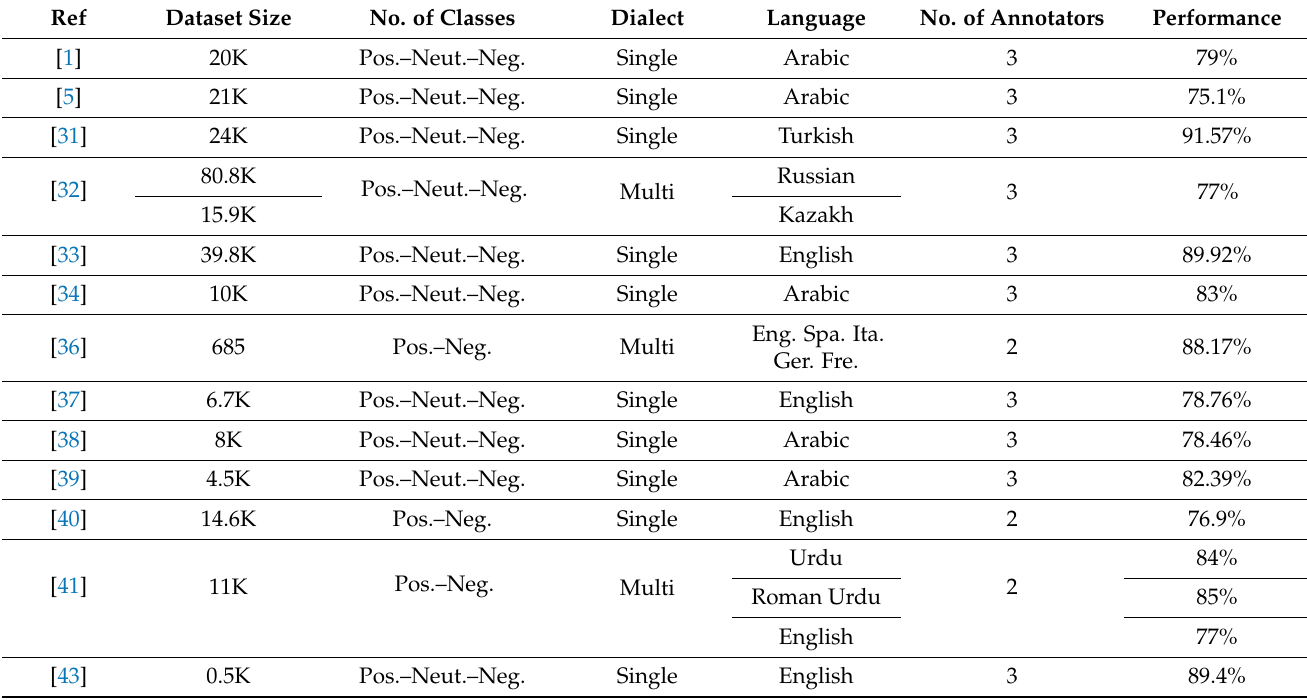
Table 2. Comparison of ML-based models with their